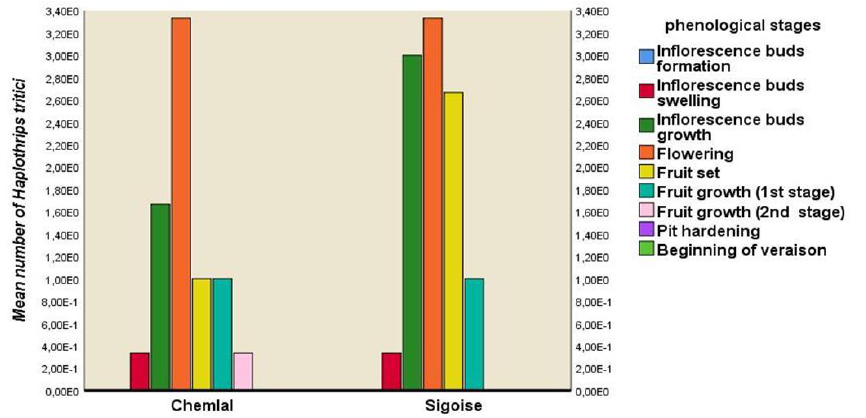
Figure 7. Mean number of H. tritici according to olive varieties phenological stages in Batna re- gion.